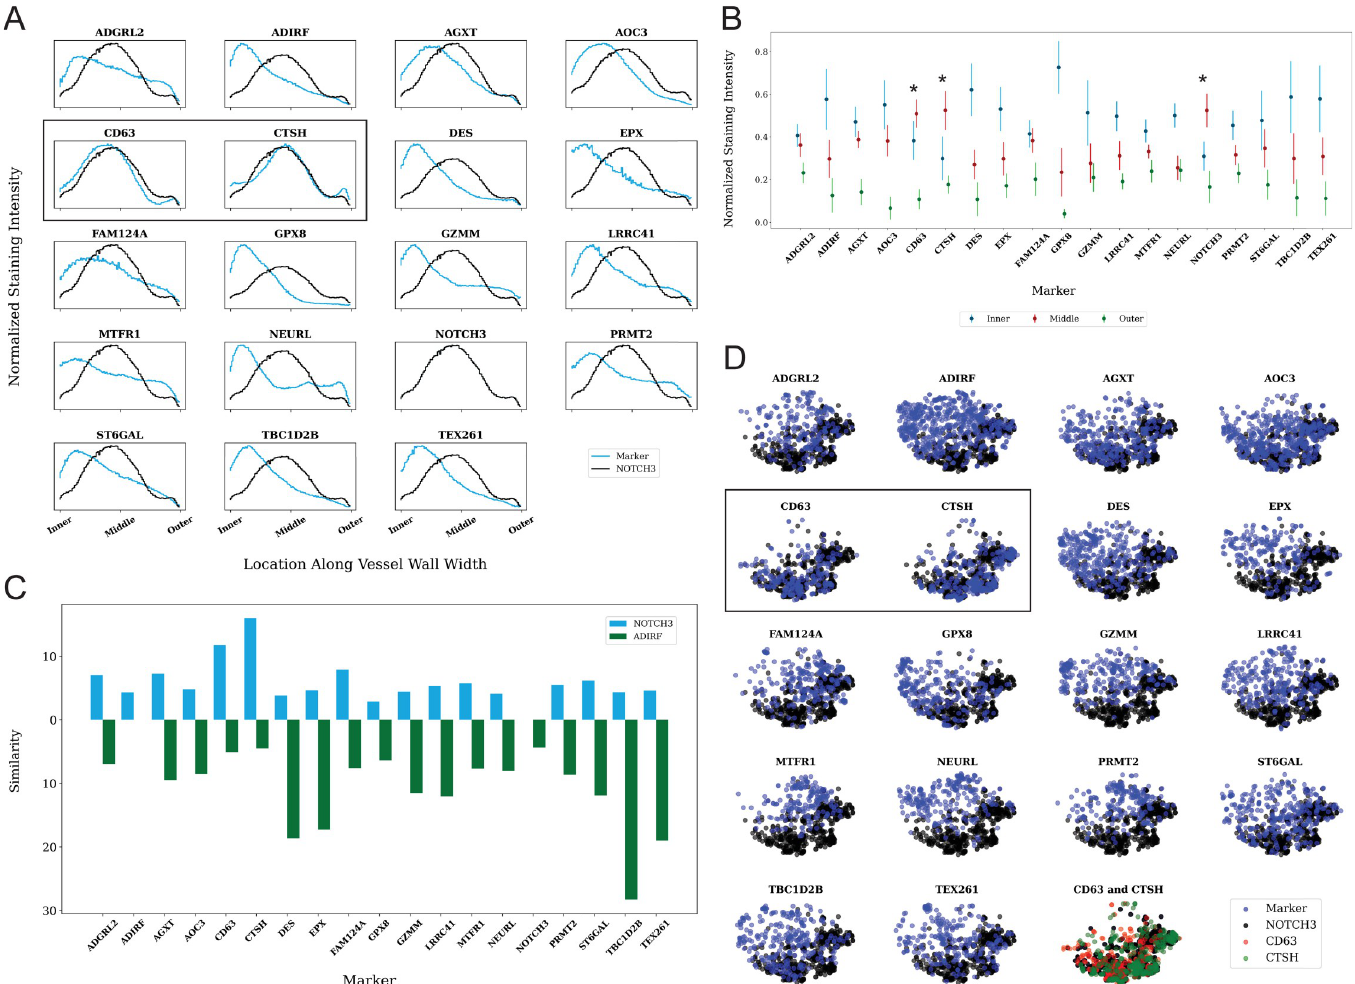
Fig 8. Quantitative analysis of marker deposition in CADASIL arteries using VesSeg. A) Mean staining distribution patterns plotted for each marker. The wall of each vessel was first split into 100 circumferential bands, and then the average staining for each region is calculated. Blue represents the marker distribution, while black indicates the reference NOTCH3 distribution. B) The staining scores for the intimal, medial, and adventitial layers of the blood vessel wall plotted by antibody. After pre- processing and segmentation, signal density maps were divided into three zones corresponding to adventitia, media, and intima. Then, the average pixel value in each layer was calculated and then normalized by subtracting the average value for the entire vessel from it. The normalized score for each layer was plotted along with standard deviation of all the vessels analyzed per marker. Red arrows show proteins which have increased expression in the media of arteries. Significant differences between the tunica intima and media staining is indicated by an asterisk; p < 0.05. C) Similarity scores between each marker and the reference NOTCH3 and ADIRF distributions. The score was calculated as the inverse Jensen-Shannon distance. D) t-SNE plots of vessel wall feature representations comparing each antibody (in black) to NOTCH3 (in blue). We used 100-dimensional vectors corresponding to the staining distribution of tangential sections of the blood vessel analysis to determine how the antibody- stained vessels are represented by our image analysis algorithm using t-distributed stochastic neighbor embedding (t-SNE). Black boxes highlight the t-SNE plot comparisons between markers with expression in the media of vessels (CD63 and CTSH). The final panel is a t-SNE plot comparing the vessel wall feature representations for NOTCH3, CTSH, and CD63 displayed